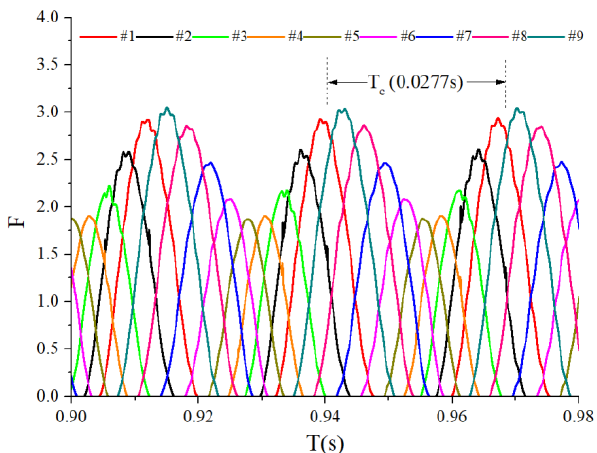
f = 1.2 N). f = 1.2 N). Figure 17. Time-domain waveform of the contact force ( f ce = 1.2 ce ce